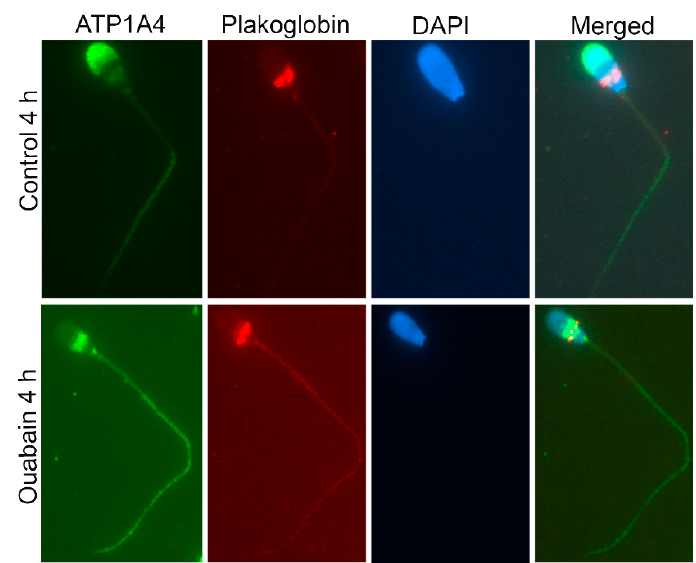
Figure 6. Co-localisation of ATP1A4–plakoglobin during sperm capacitation. Representative images (60 × ) of (green) ATP1A4, (red) plakoglobin, (blue) nuclei and merged plakoglobin, ATP1A4 and DAPI staining in control 4 h and ouabain 4 h capacitated sperm.